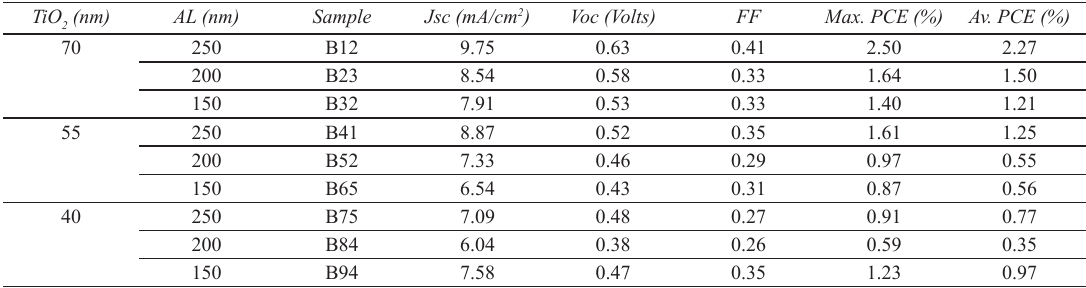
/P3HT:PC BM/MoO /Ag 2 61 3